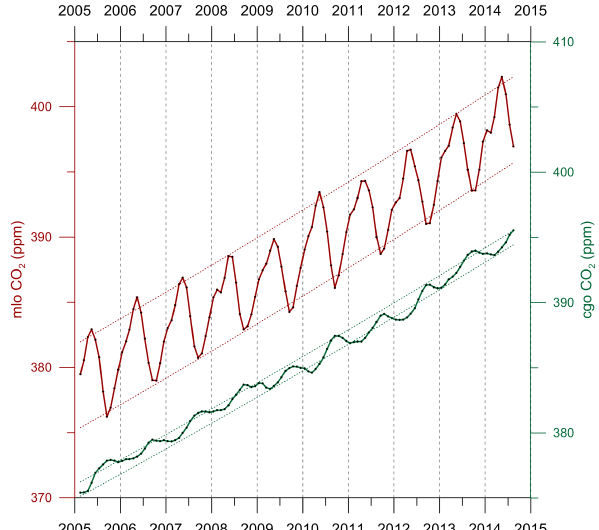
Figure 3. Monthly mlo and cgo CO 2 time series: CSIRO data of Fig. 1a are plotted monthly to better examine the onset of the 2009– 2010 step (see